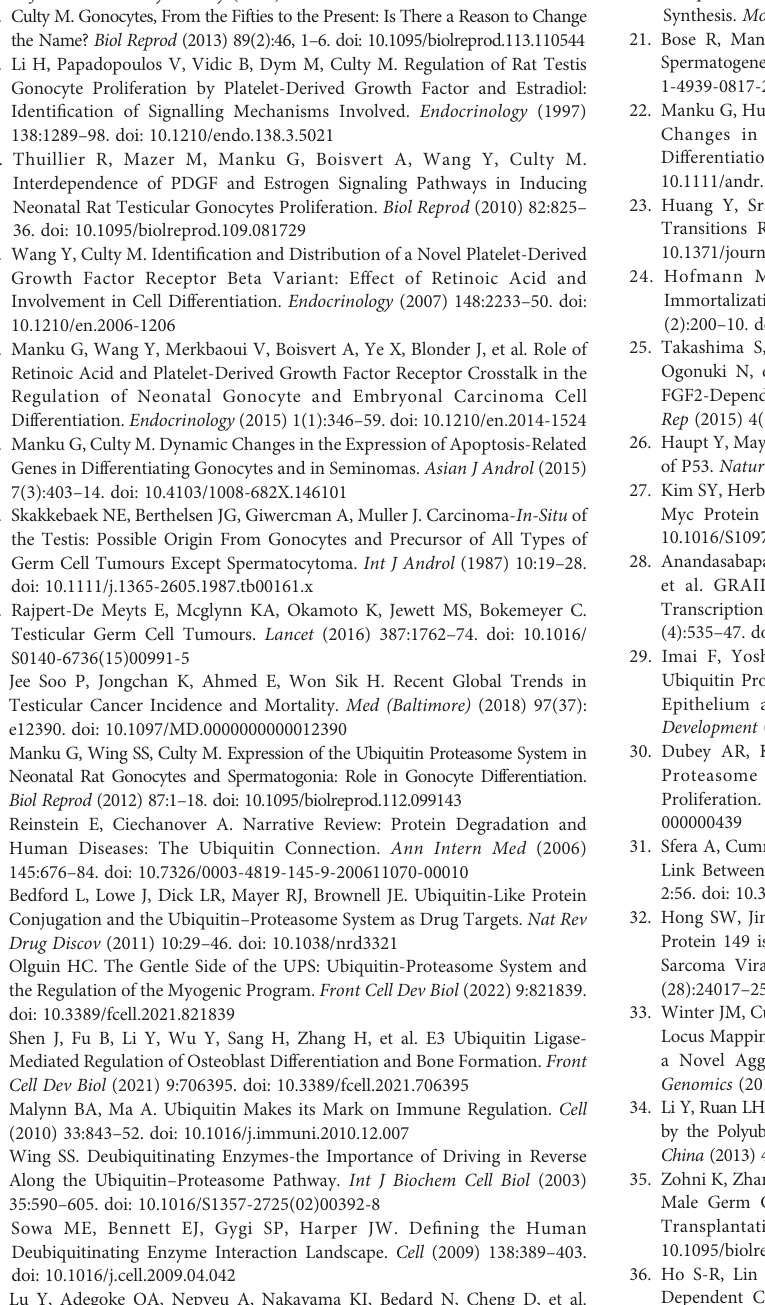
Supplementary Figure 1 | Gene map of RNF149-EGFP plasmid. (A) RNF149 VA1-EGFP gene map. (B) RNF149 VA2-EGFP gene map.